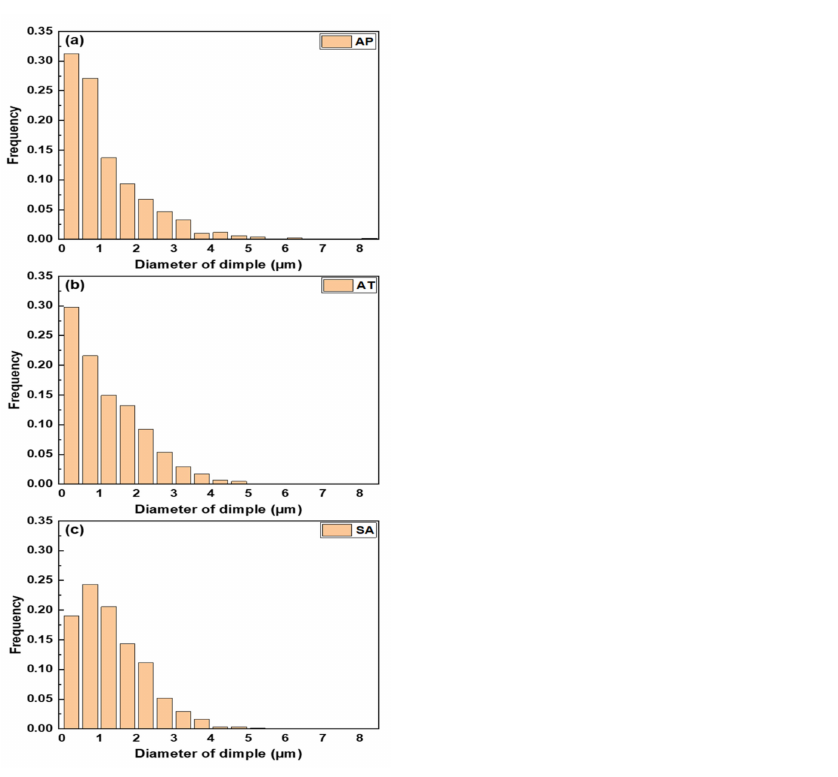
Figure 9. Dimple size distribution of tensile fracture at ( a ) AP, ( b ) AT and ( c ) SA